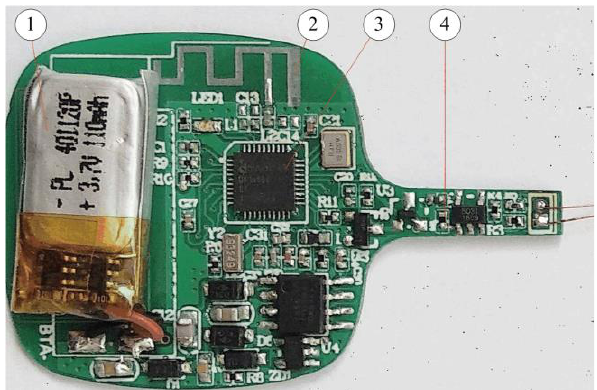
Figure 11. The developed PCB of the smart clinical thermometer: (1) lithium-ion battery, (2) antenna, (3) DA14580 chip, and (4) the fixed resistor R f .